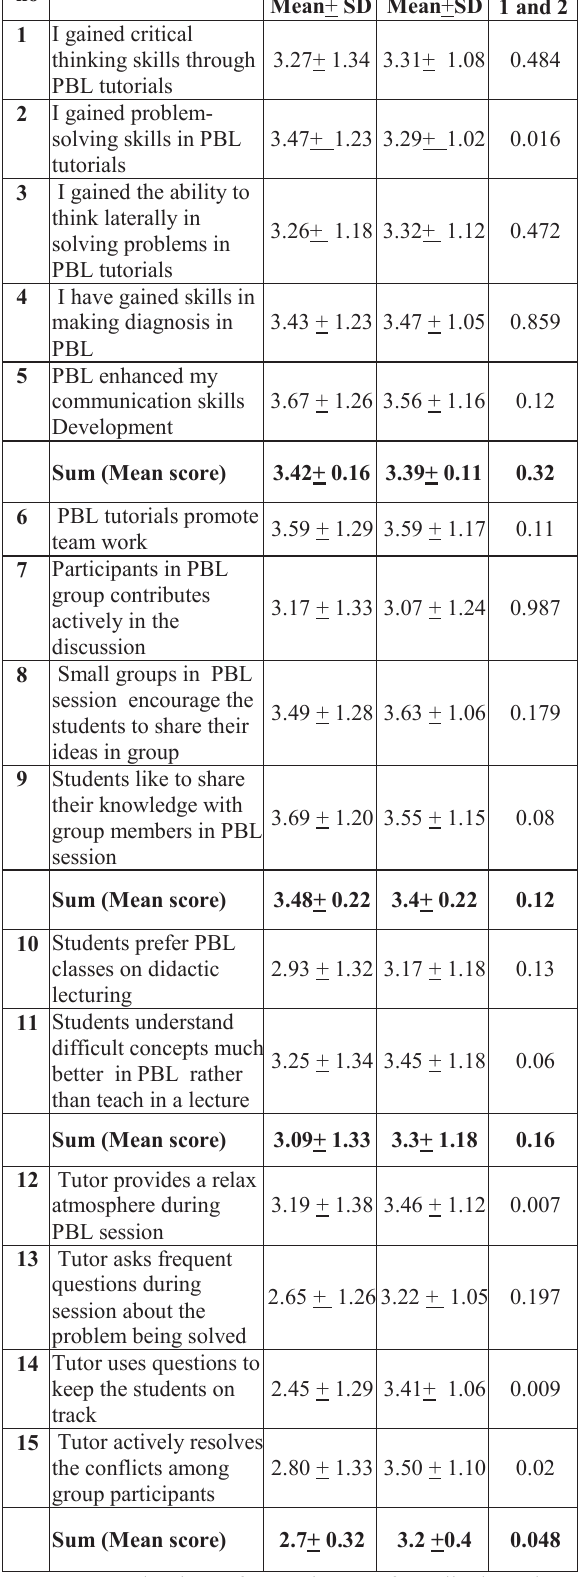
Table-1: Evaluation of experience of medical students regarding PBL in two different